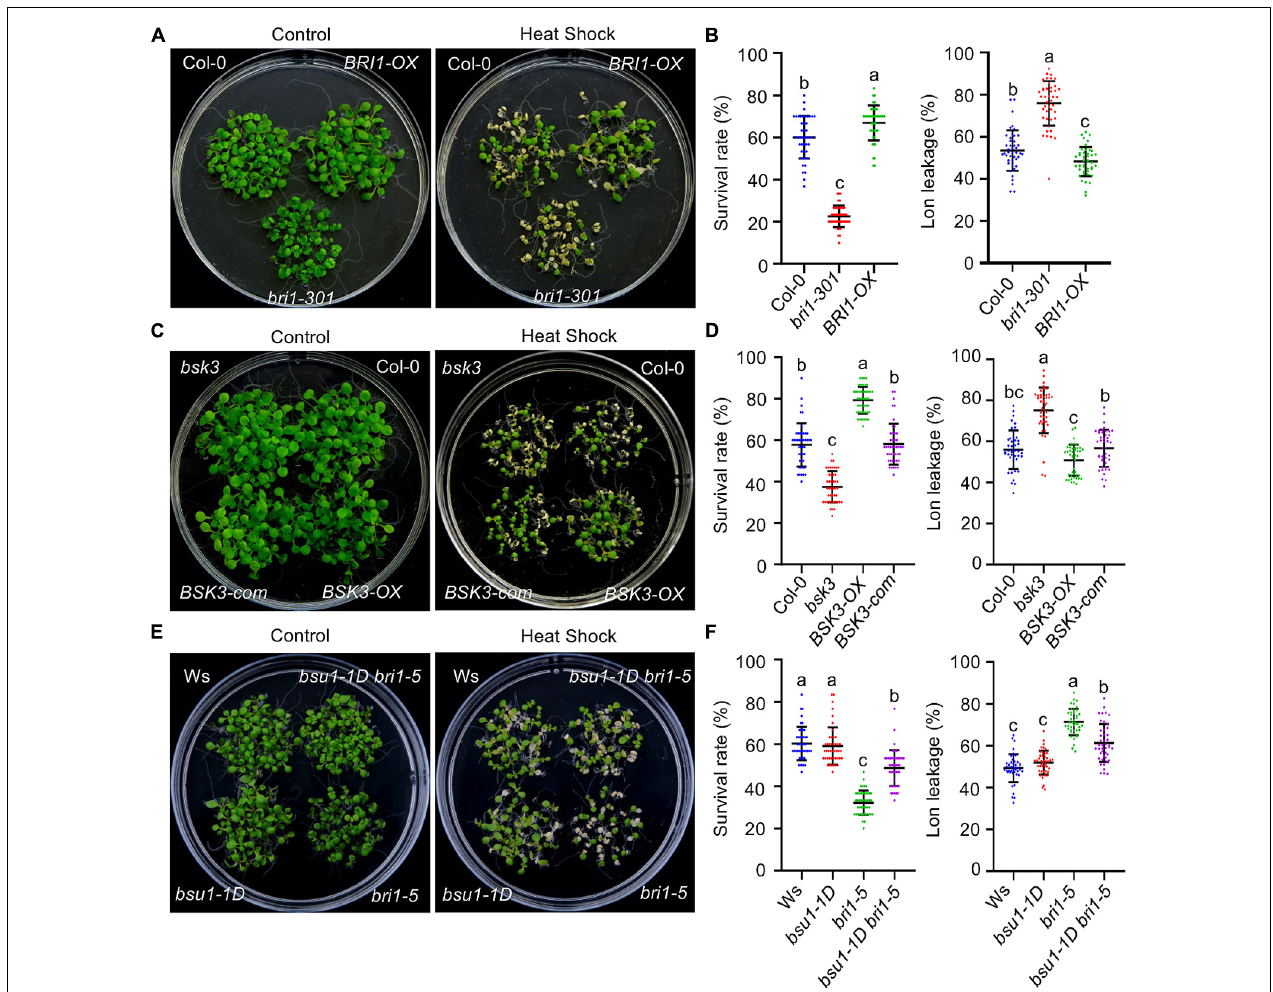
FIGURE 2 | The BR signaling components BRI1, BSK3, and BSU1 regulate acquired thermotolerance in Arabidopsis . (A,C,E) Photographs of HS-treated and untreated plants after 3 days of recovery at 22 ◦ C. (B,D,F) Quantification of the survival rates of and ion leakage from the plants shown in panels (A,C,E) . Error bars indicate the mean ± SD. Statistically significant differences are indicated by different lowercase letters ( p < 0.05, one-way